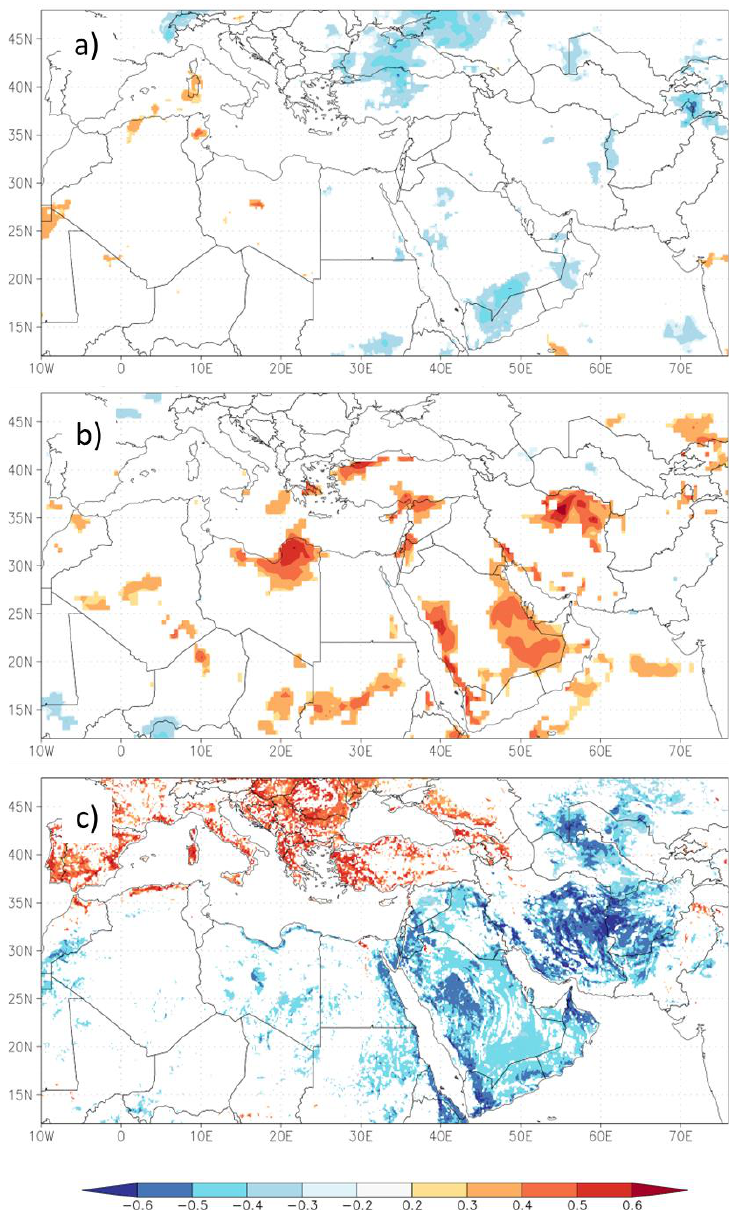
Figure 10. Correlation coefficients between the EAP dust mass density and precipitation ( a ), mean maximum daily wind speed ( b ), and NDVI ( c ) during the dust season of April – August. The maps cover the entire study region of 12 – 48° N, 10° W – 76° E; they were produced using the KNMI Climate Explorer web tool (https://climexp.knmi.nl/start.cgi (last accessed on 21 August 2022)).